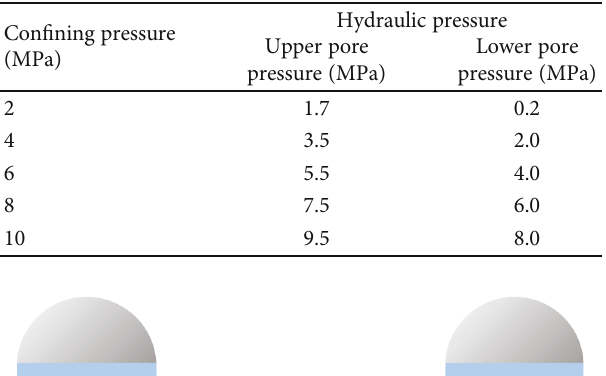
Table 2: Pore pressure at upper and lower ends.